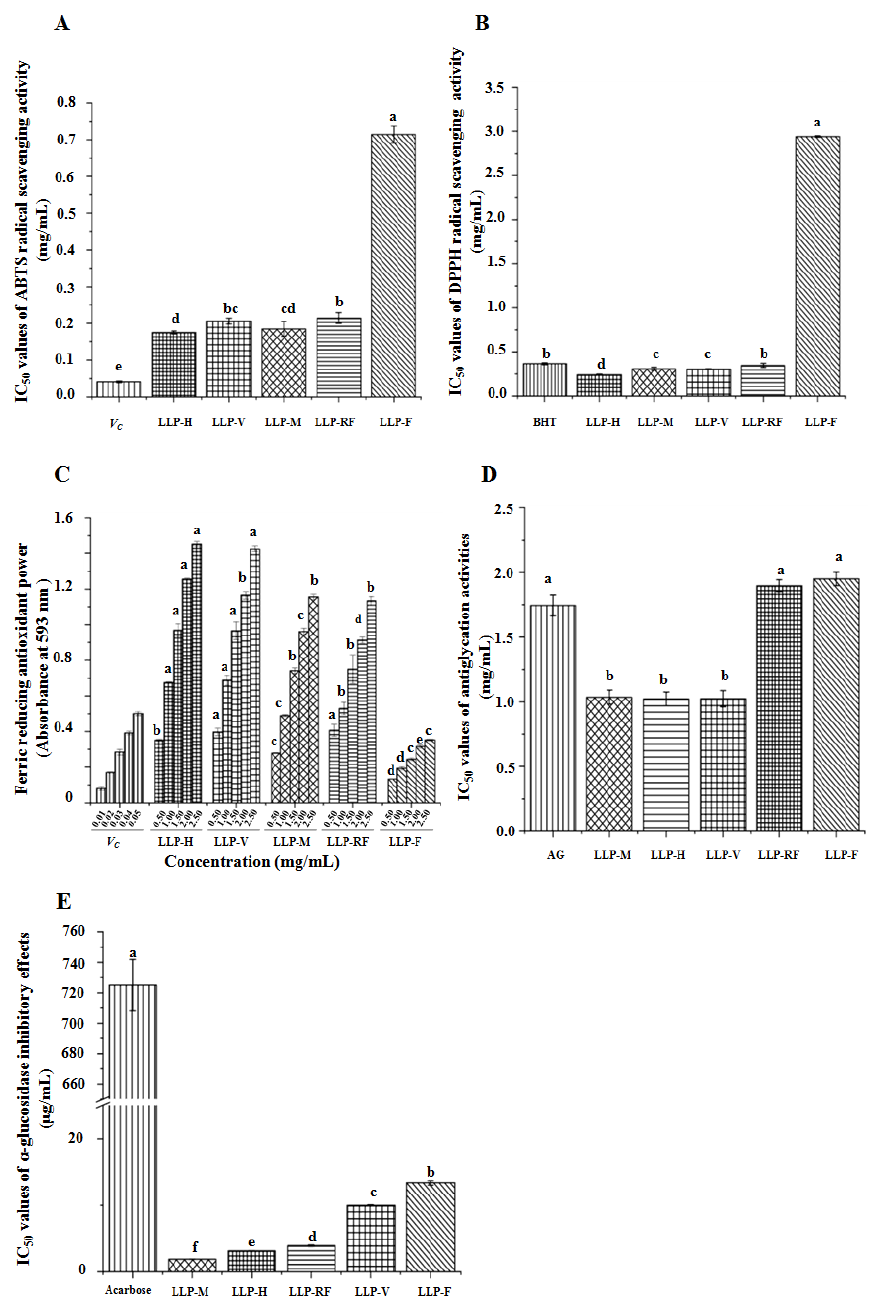
Figure 5. ABTS ( A ), DPPH ( B ), and FRAP ( C ) antioxidant capacities, antiglycation activities ( D ), and inhibitory effects on α-glucosidase ( E ) of LLPs. inhibitory effects on α -glucosidase ( E ) of